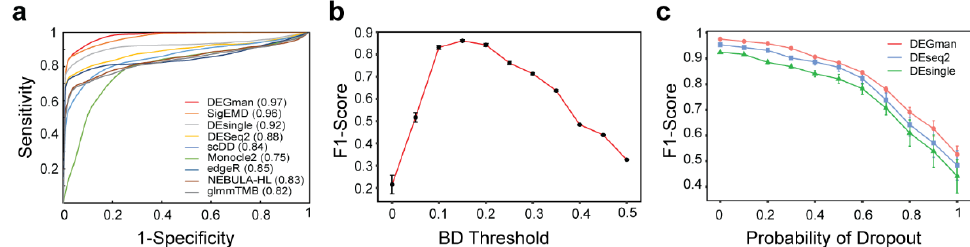
Figure 2. The performance of DEGman. ( a ) ROC curves and AUC values of nine DEG analysis tools using simulated data. ( b ) The F1-scores of DEGman on simluated data with different thresholds of Bhattacharyya distance. ( c ) The F1-scores of DEGman, DEseq2 and DEsingle for different dropout levels. Table 1. Performance comparison of ten tools on the simulated data. Adjusted p -value < 0.05.